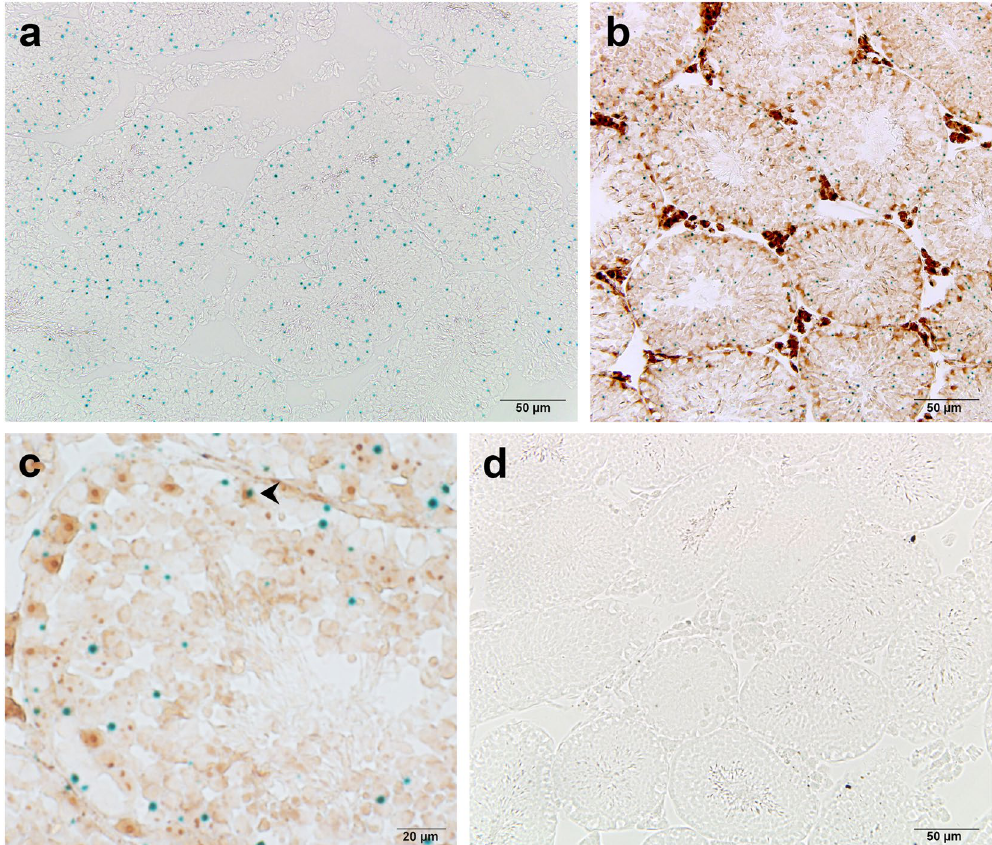
Figure 1. PLAG1-expressing cells in adult mouse testis. ( a ) lacZ -positive cells (blue) in a representative testis section of a 5-week-old Plag1 knock-out animal, as determined by X-gal staining. ( b , c ) Expression of lacZ (blue; X-gal staining) was found mostly in germ cells and only occasionally (arrowhead) in Sertoli cells (brown, GATA4 immunostaining). ( d ) Wild-type negative control for X-gal staining, showing no blue